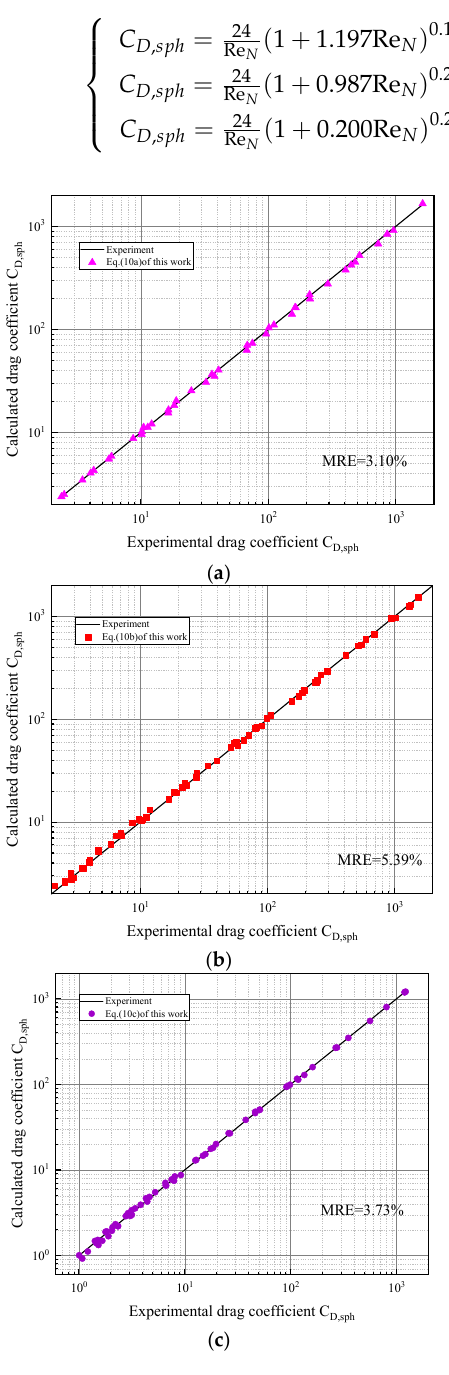
Figure 8. Comparison between predicted value and experimental data of CD of spherical particles: ( a ) NF; ( b ) PLF; ( c ) HBF.